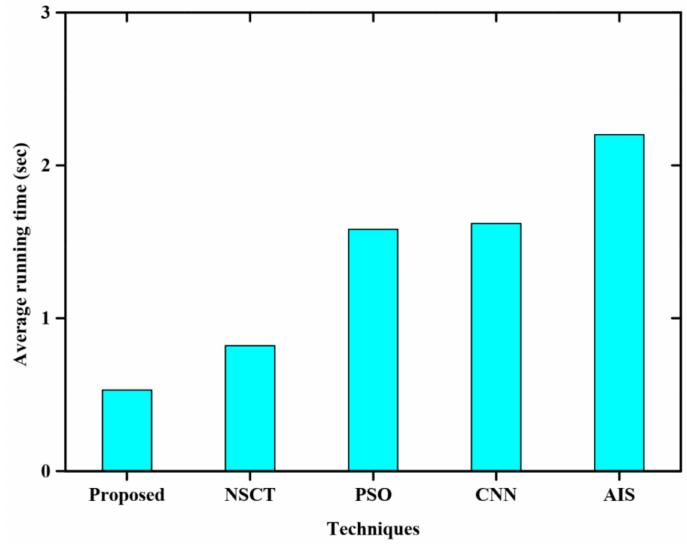
Figure 4. Average running time